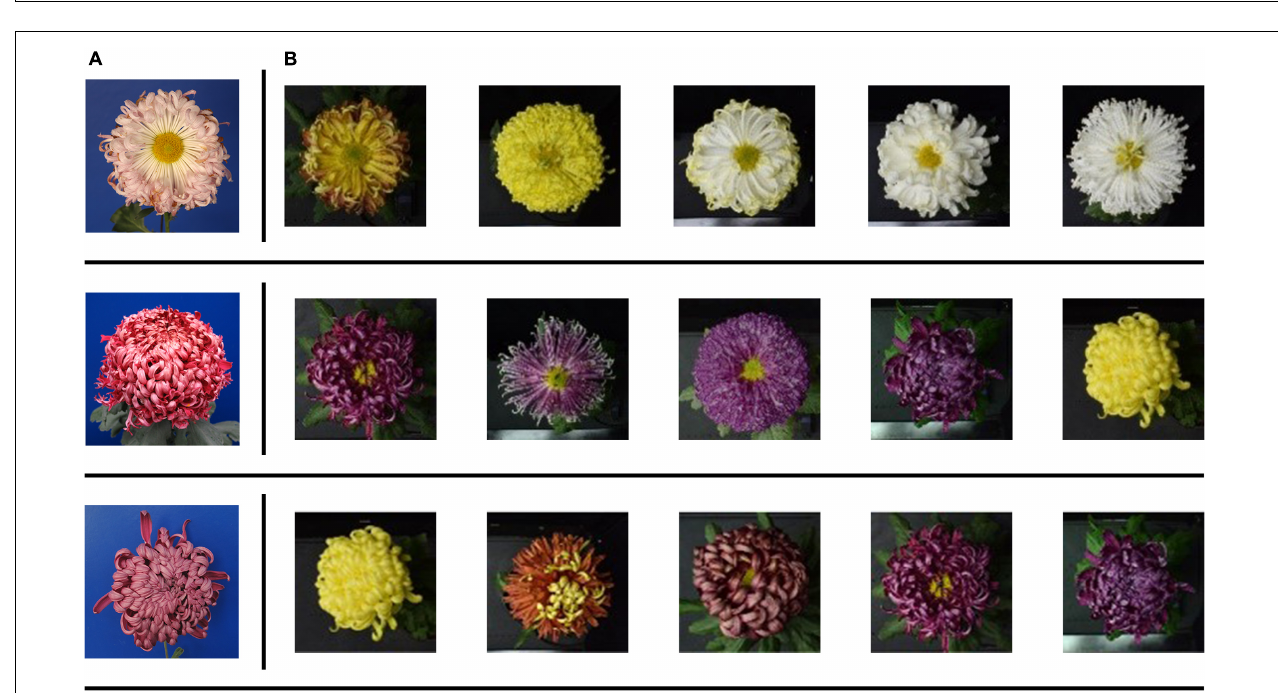
FIGURE 2 | Examples of misclassified images by the pre-training model. (A) The test images. (B) The Top-5 results.